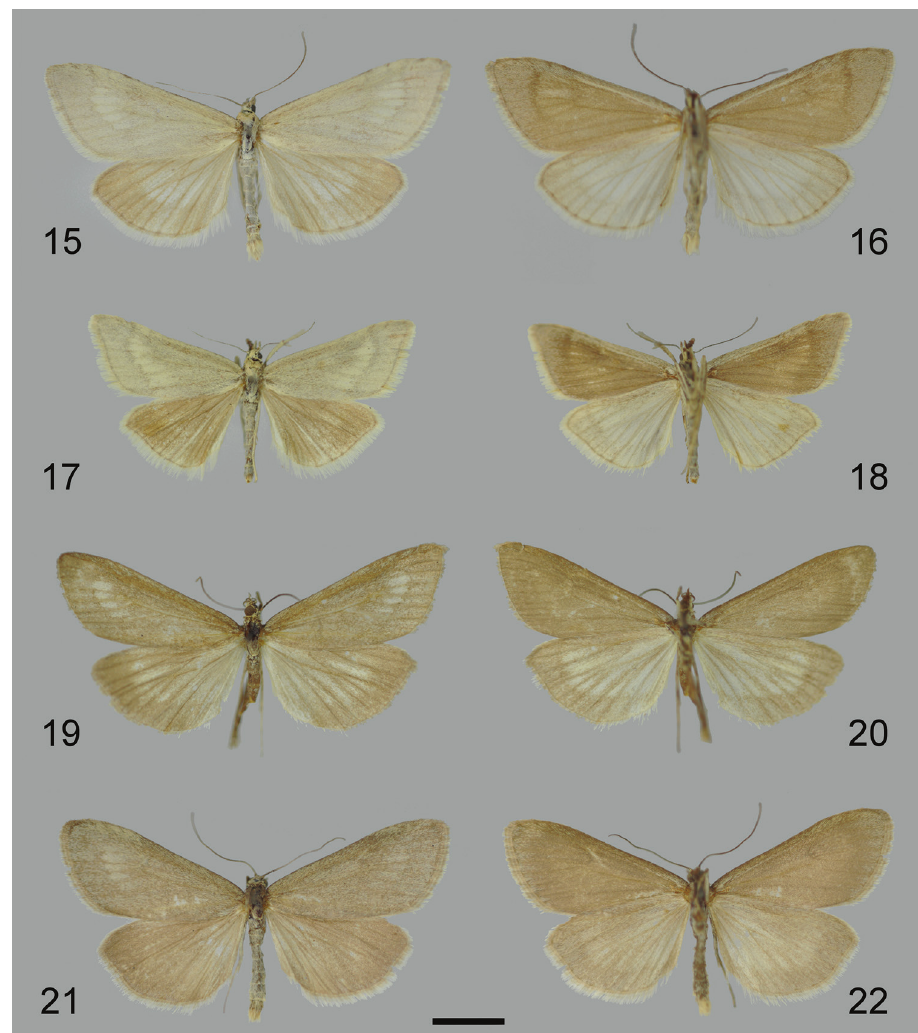
Figures 15–22. Adult specimens of Udea species. 15–18 U. altaica 15–16 male, dorsal ( 15 ) and ventral ( 16 ) 17–18 Lectotype (NHMW) female, dorsal ( 17 ) and ventral ( 18 ) 19–20 U. juldusalis Lectotype (NHMW) male, dorsal ( 19 ) and ventral ( 20 ) 21–22 U. plumbalis Holotype (NHMW) male, dorsal ( 21 ) and ventral ( 22 ). Scale bar: 500 Redescription. Head . As for U. austriacalis , part from: frons and vertex with cream-white scales; distal half of labial palps brown on the outside, basal half and in- ner sides cream white; maxillary palps cream-white with some brown scales mixed in; antennal length approx. 60 % of forewing length in males, approx. 70 % in females. Thorax . As for U. austriacalis , apart from: legs cream-white on inner and outer sides; proximal pair of metatarsal spurs with outer spur minute and inner spur long,